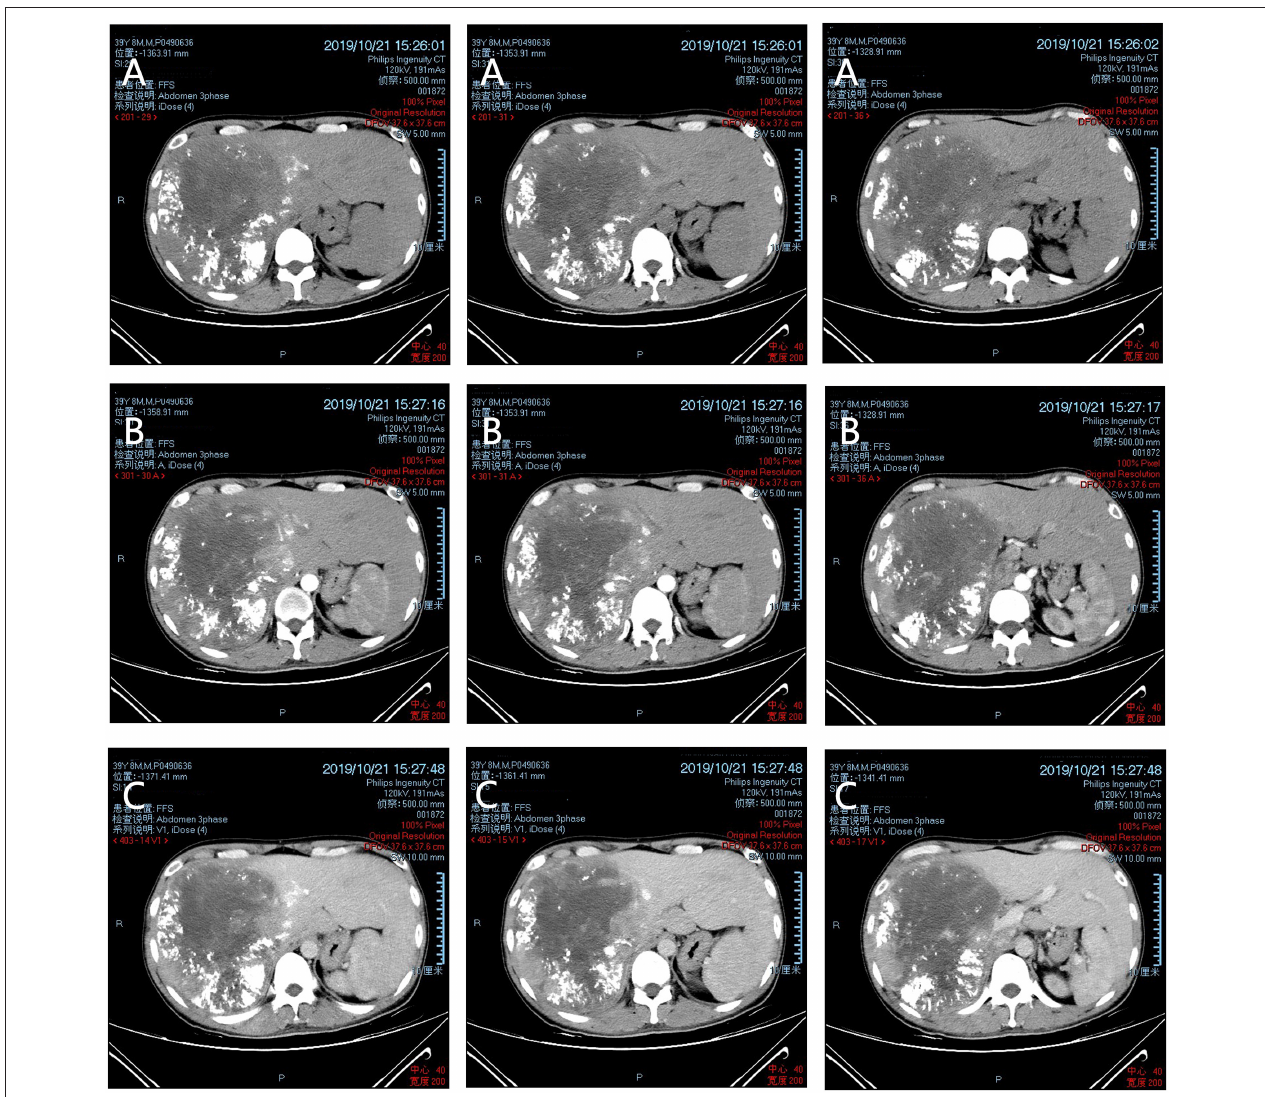
FIGURE 2 | CT images after TACE. (A) Plain scan; (B) arterial phase; and (C) portal venous